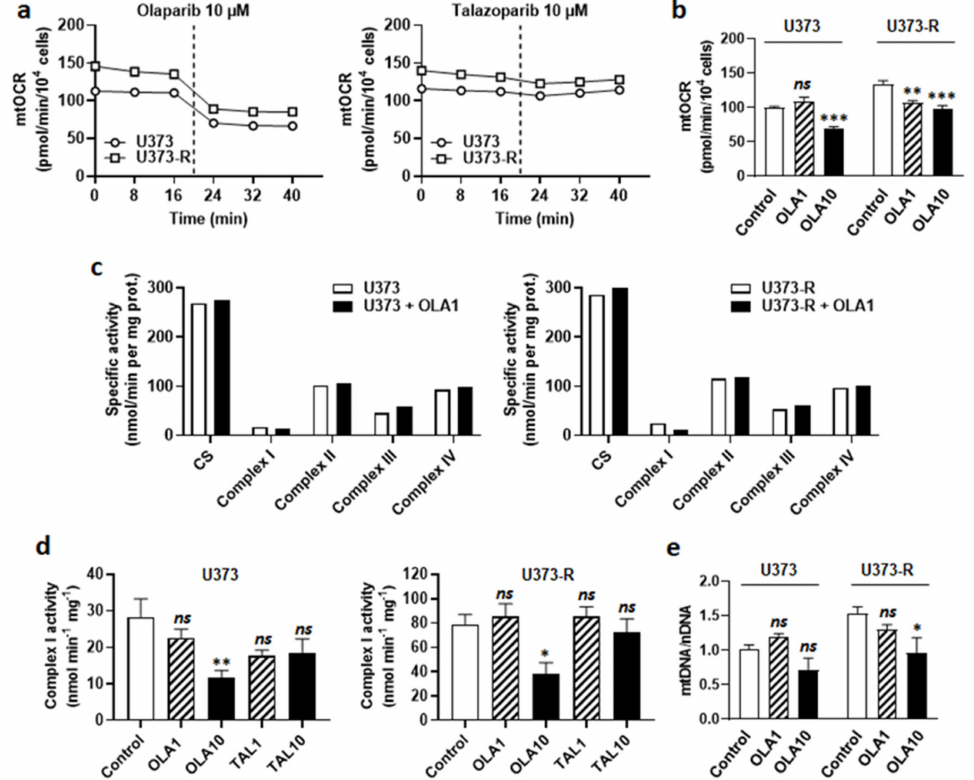
Figure 6. PARP inhibitor olaparib, but not talazoparib, is an ETC Complex I inhibitor. ( a ) U373 and U373-R glioblastoma cells that were treated with 10 µ M olaparib or 10 µ M talazoparib delivered as a bolus (dotted line) during basal